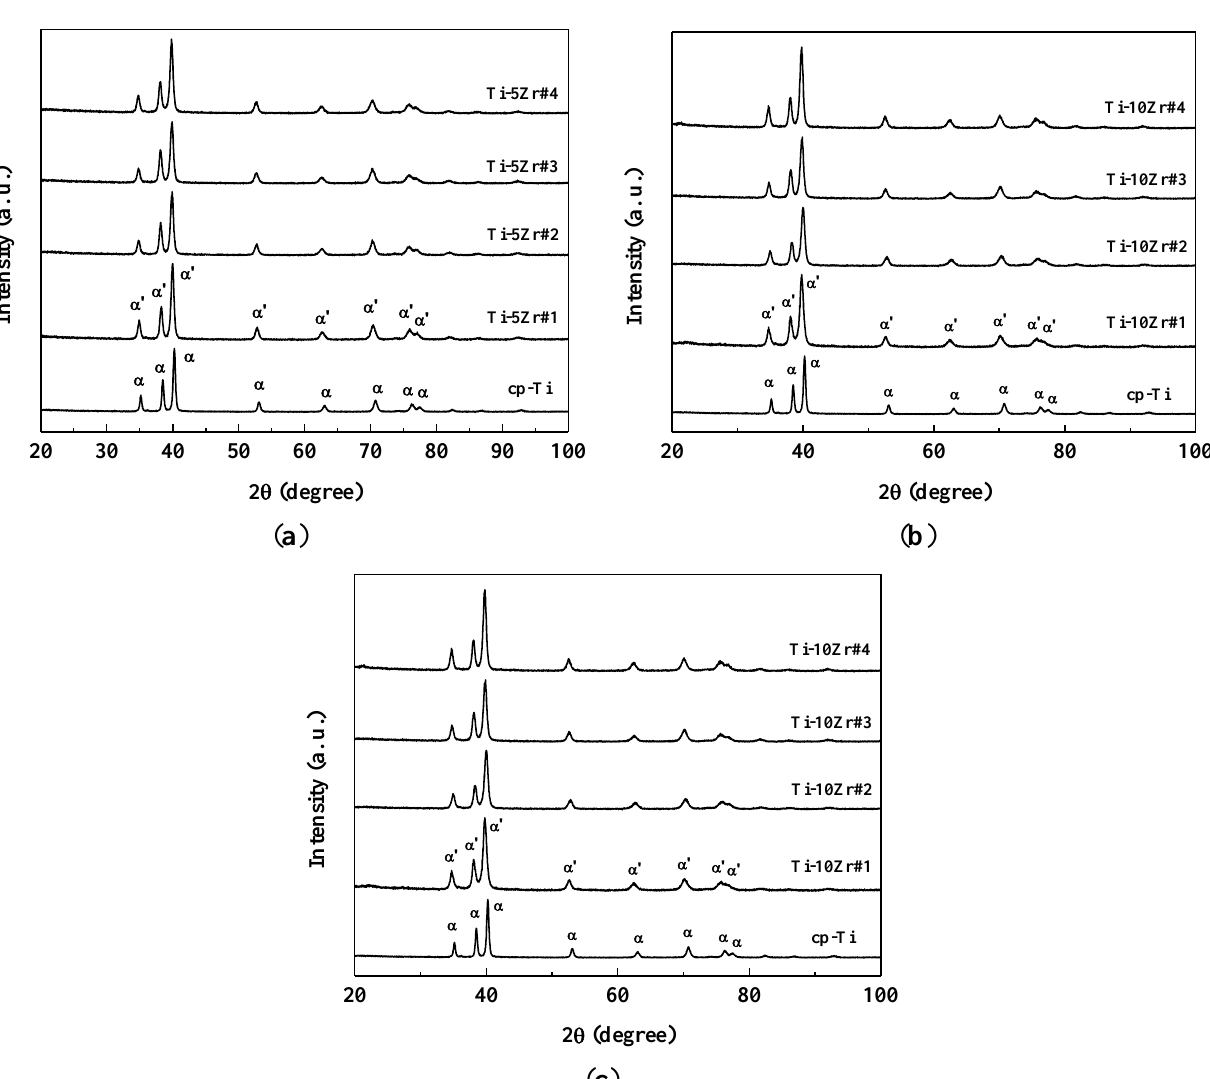
Figure 2. X-ray diffractograms for ( a ) Ti-5wt%Zr (Ti-5Zr); ( b ) Ti-10wt%Zr (Ti-10Zr)